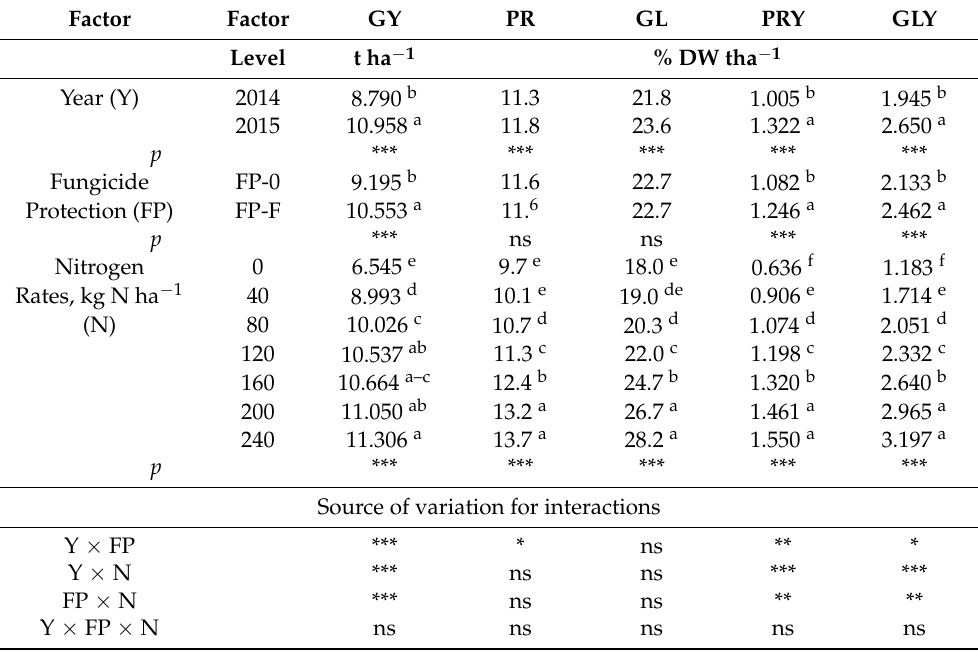
Figure 1. Effect of winter wheat protection with fungicides and rates of fertiliser nitrogen on grain yield. Similar letters indicate a lack of significant differences using Tukey’s test. The vertical bar in the column refers to the standard error of the mean. Table 2. Basic characteristics of winter wheat yield in 2014 and 2015 growing seasons.